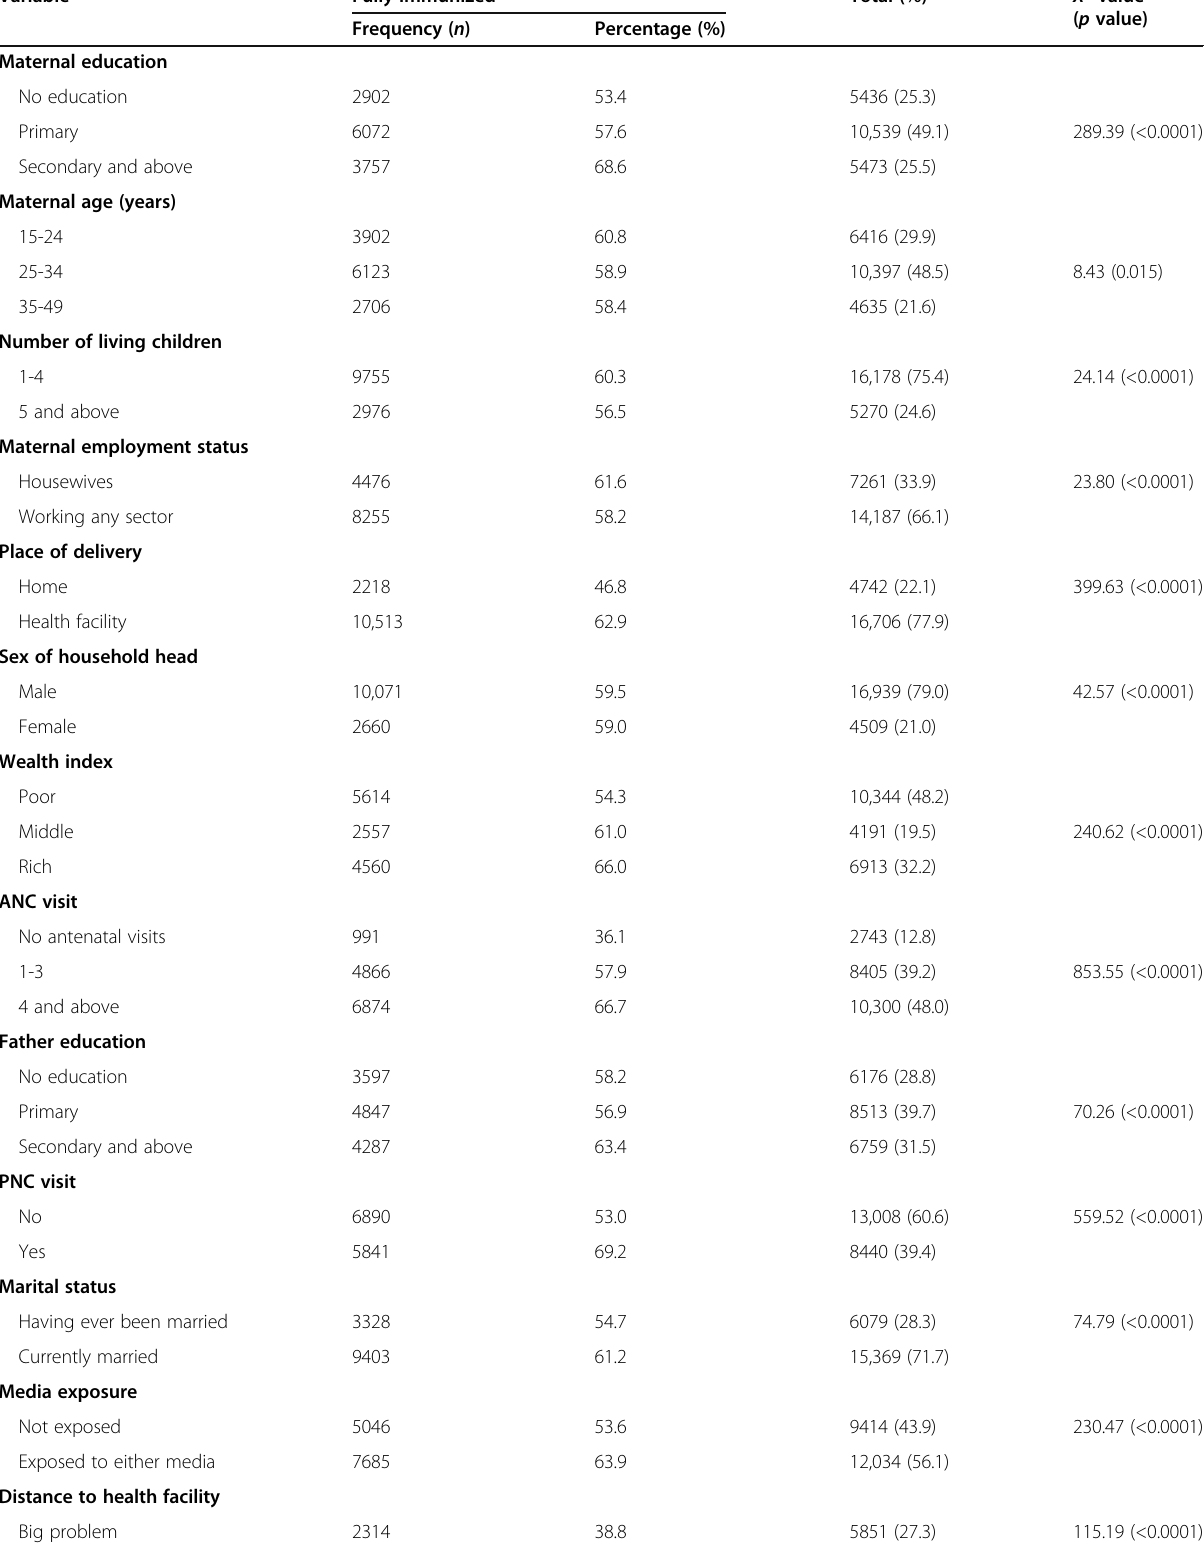
Table 2 Socio-demographic, economic, maternal, and obstetric characteristic respondents in the 12 sub-Saharan African countries